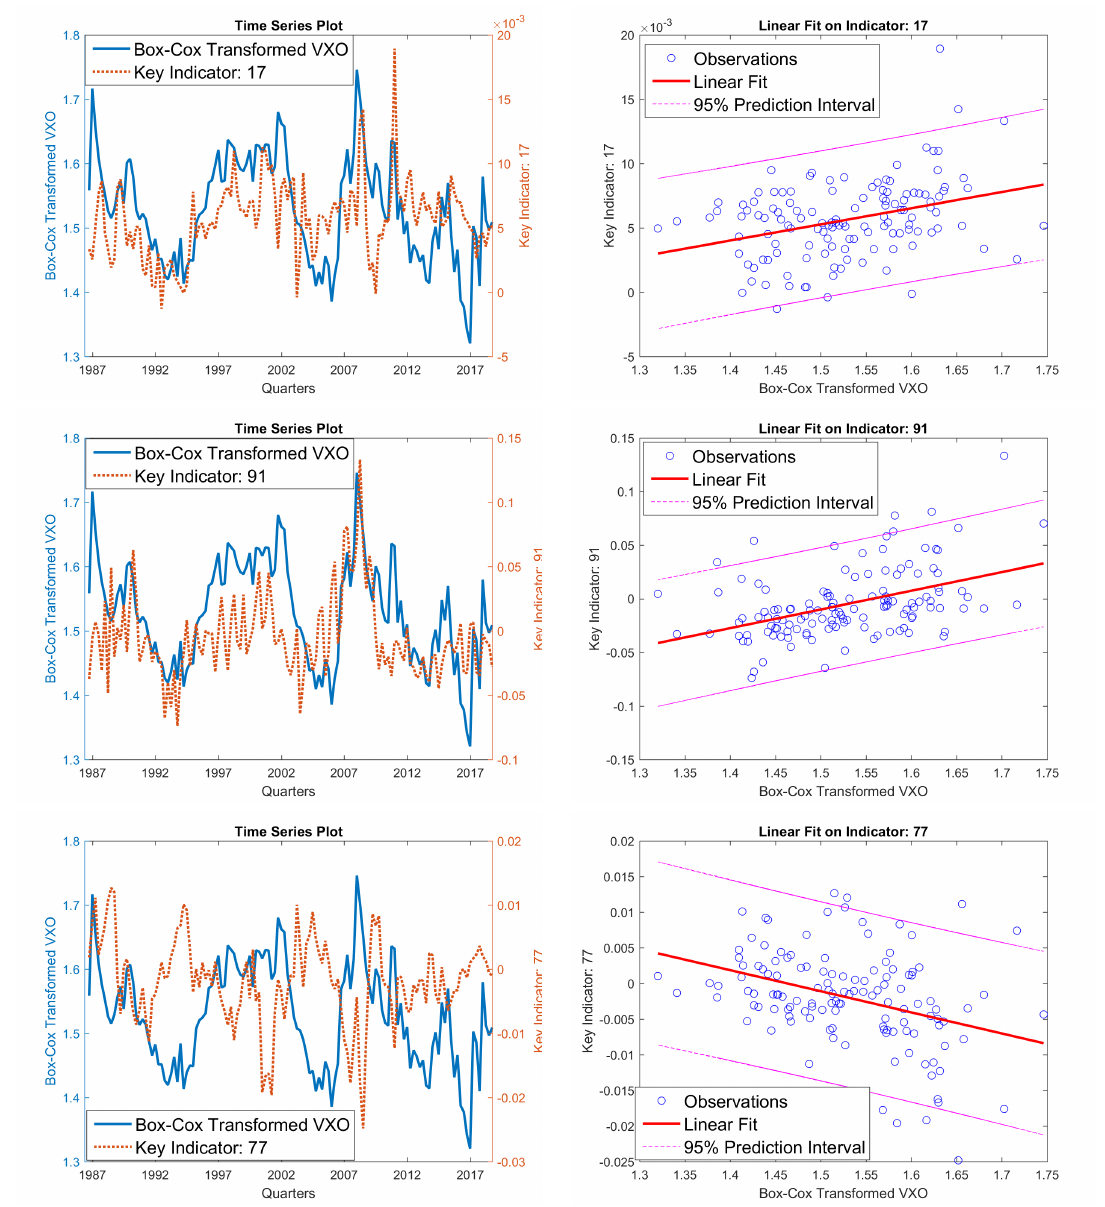
Figure 10. Pairs plot between Box–Cox transformed VXO and significant indicators. ( Top panels ) are time series plots and linear fitting plots on indicator 17 (yield spread between Aaa corporate bond and federal fund rate); ( middle panels ) is on indicator 91 (issuance of non-financial corporate bonds); ( bottom panels ) are on indicator 77 (total outstanding non-revolving credit). We find that two indicators (17 and 91) have upward slopes, and indicator 77 has a downward